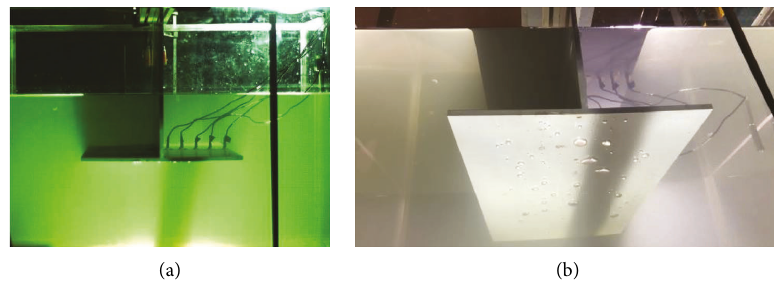
Figure 8: Flow pattern of the initial acceleration